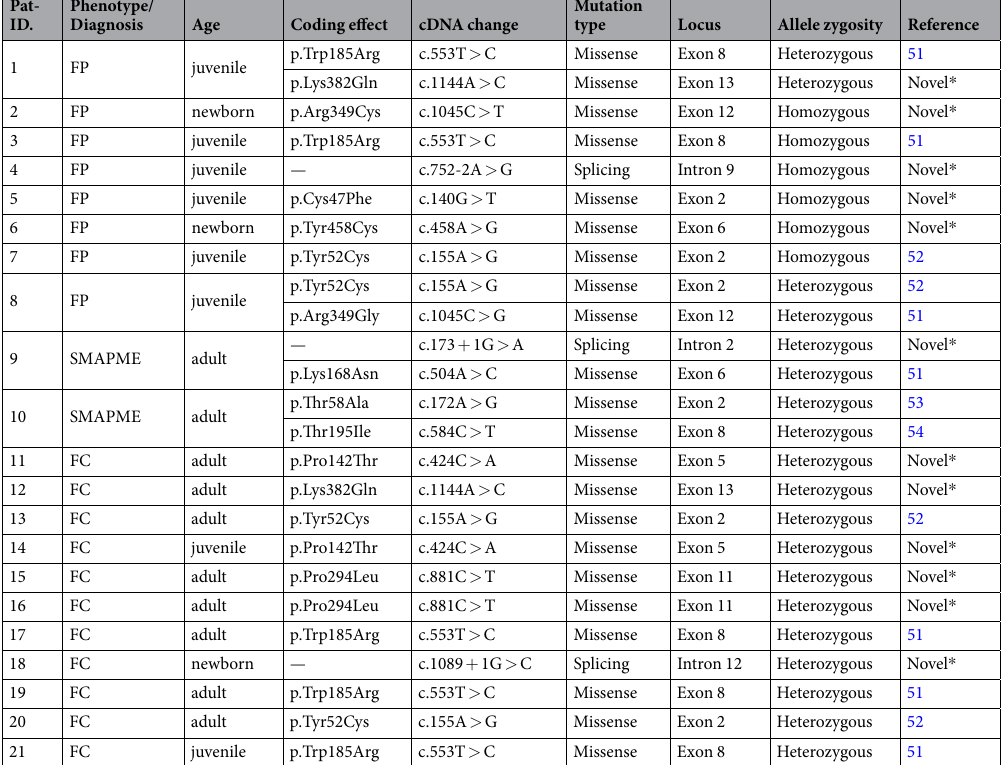
Table 1. ASAH1 mutations found in FP and FC involved in present study (results obtained with ASAH1 transcript NM_004315.4). FP = Farber patients, SMAPME = spinal muscular atrophy associated with progressive myoclonic epilepsy, FC-asymptomatic Farber carriers, Newborn = patients or carriers with age up to 6 months, Juvenile = patients or carriers with age 6 months to 4 years, Adults = patients or carriers with plus 17 years old. * CentoMD